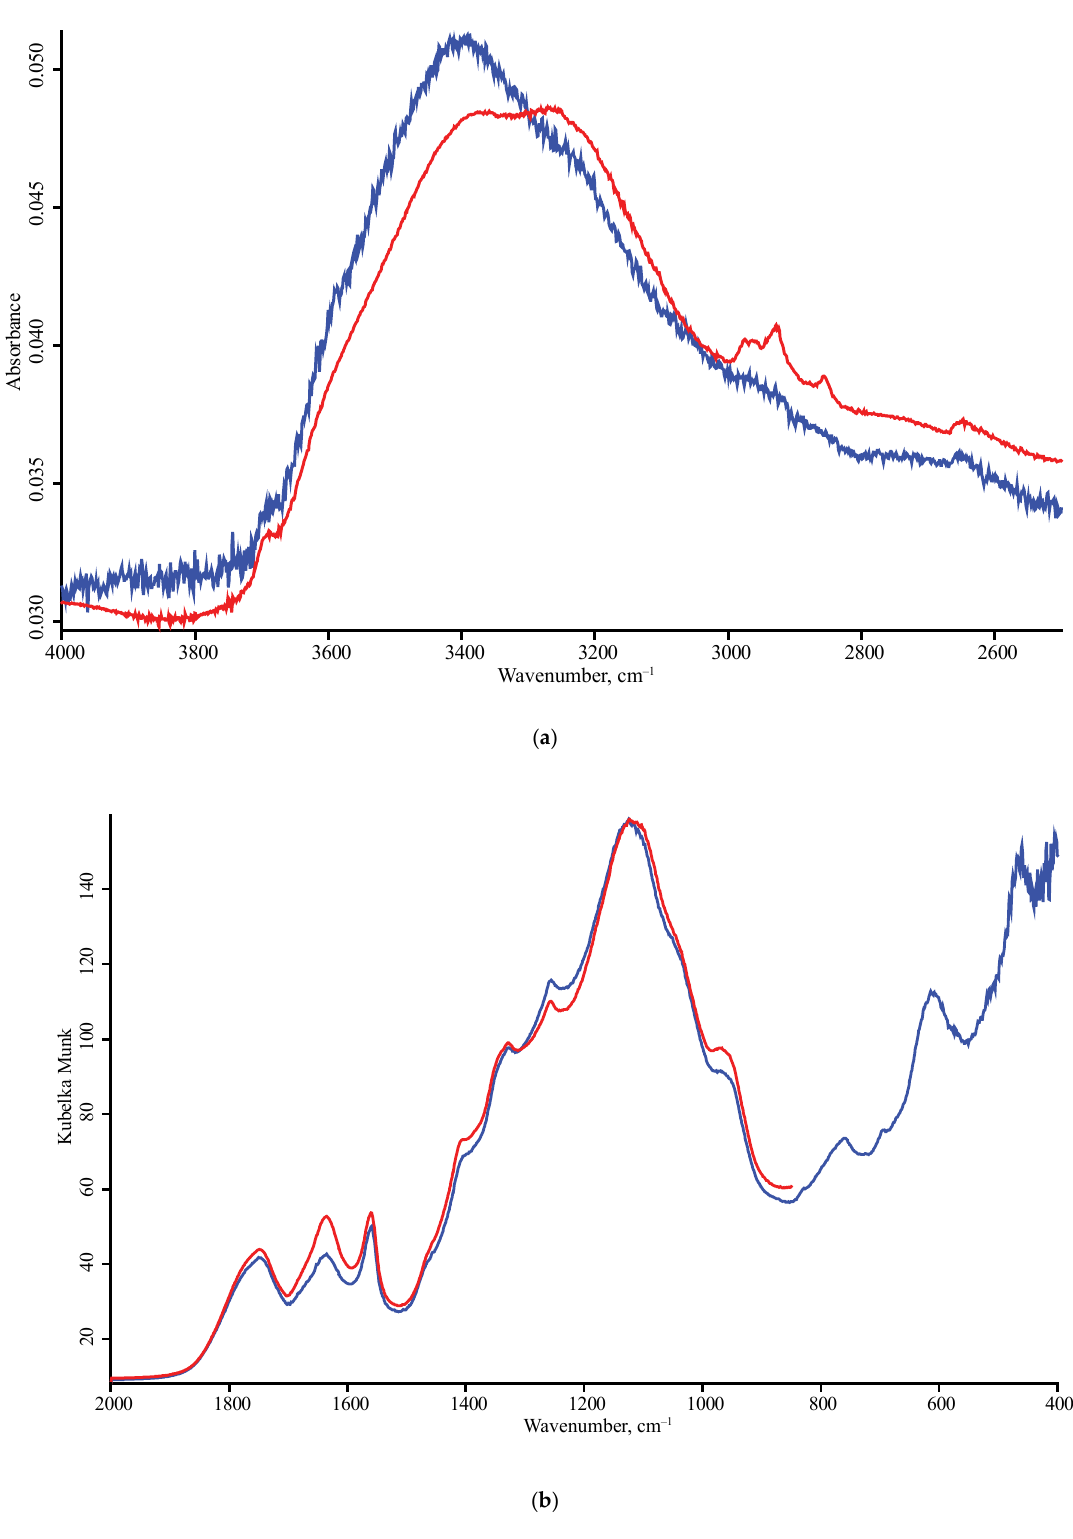
Figure A6. Diffuse reflectance mode (mirror was used for background collection), UDA-SP nanodiamonds; red, LN-MCT photovoltaic detector; blue, DLaTGS detector ( a ) 4000–2000 cm − 1 , ( b ) 2000–400 cm − 1 range. Spectra were not smoothed but normalized to maximize each spectrum.